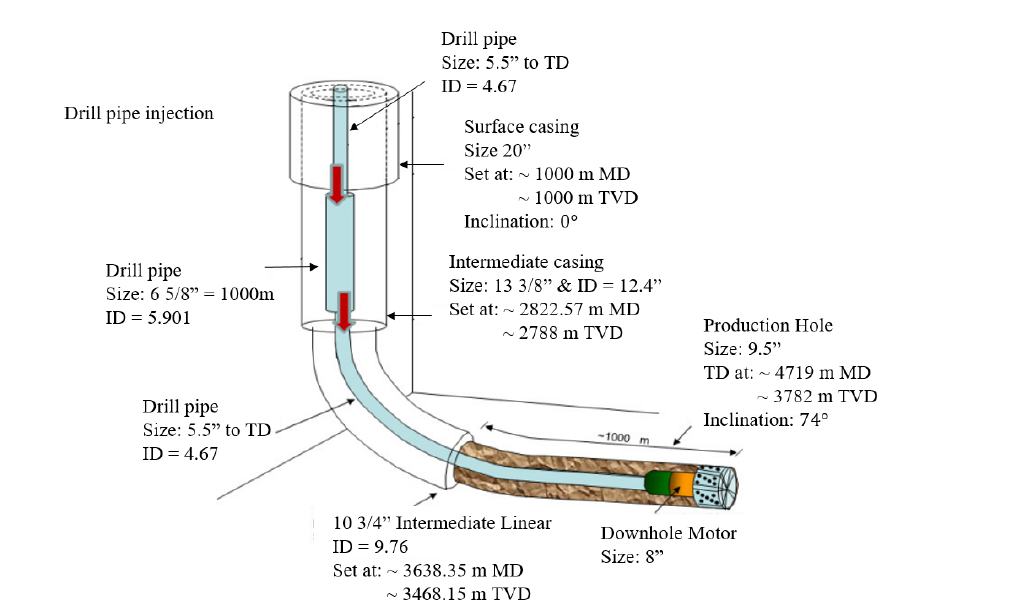
Figure 1. Drill pipe injection profile (courtesy of [8]).